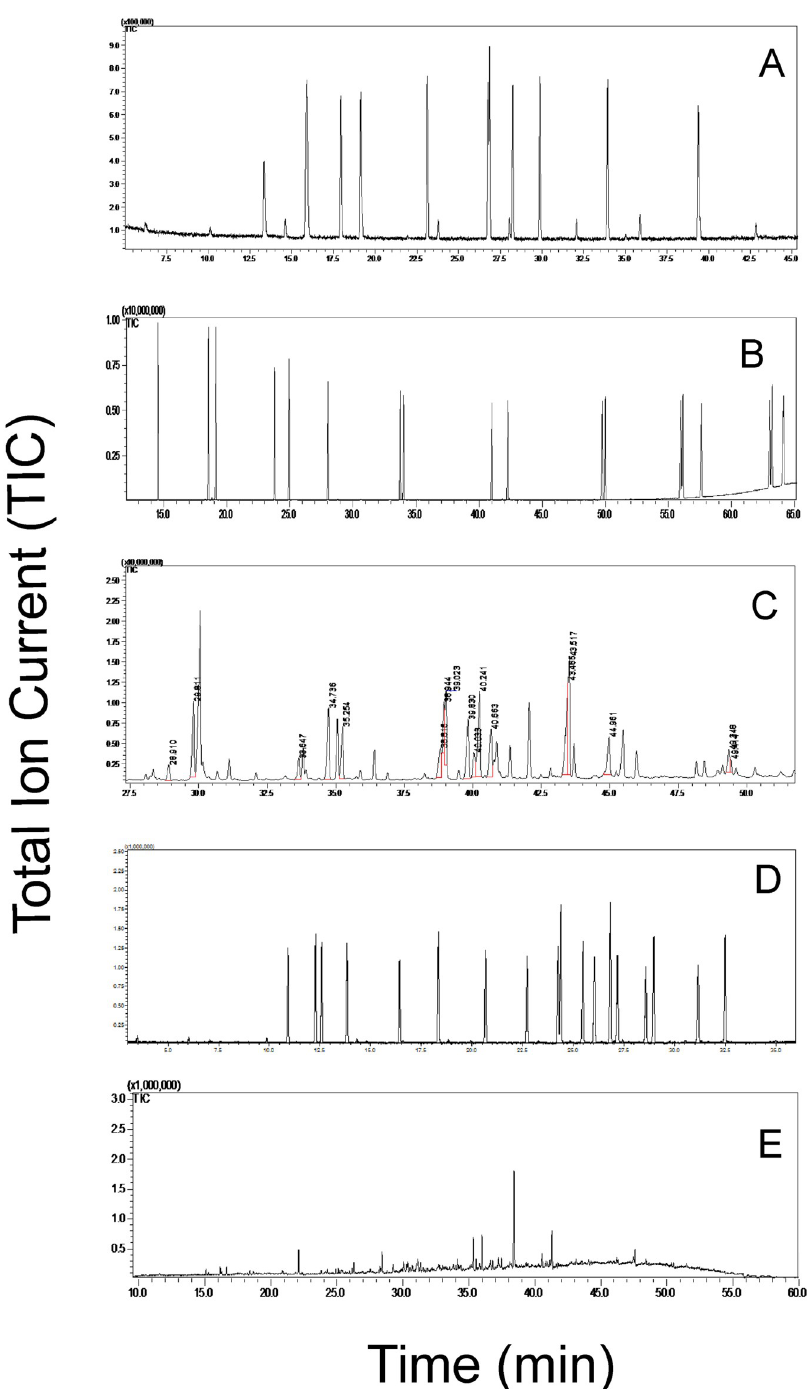
Fig 2. The total ion current (TIC) chromatograms of: (A) PAH standards, (B) PCB standards, (C) dioxins’ standards, (D) pesticide standards, (E) soil sample collected in Rudenka. List of standards used, their retention times (RT) and limits of detection (LOD) is presented in S1